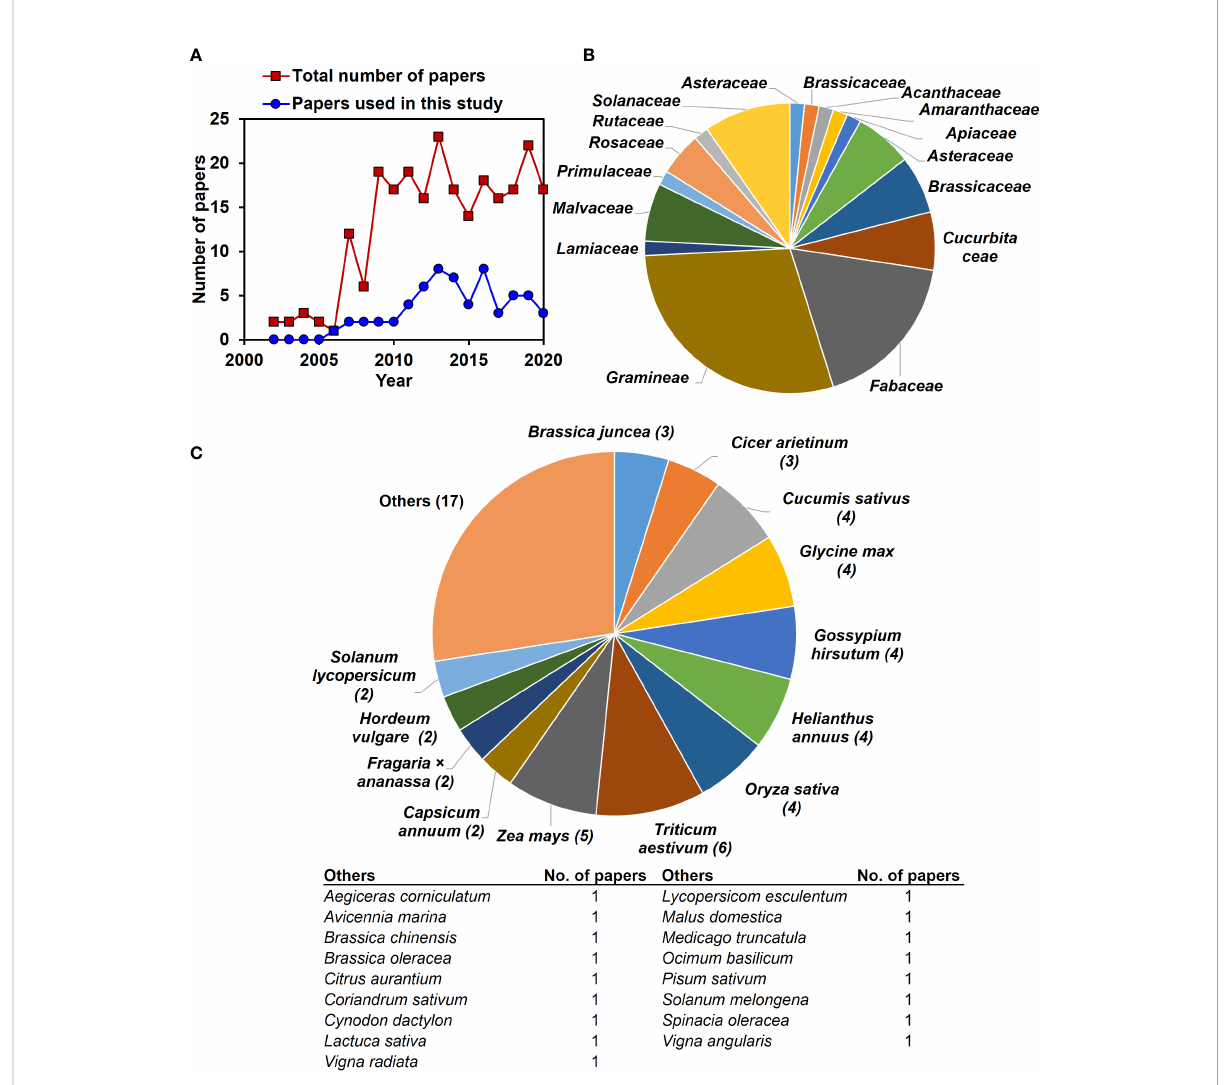
FIGURE 2 The total number of published articles, plant families and species about exogenous NO effects on plant stress physiology for salt tolerance available in the ‘ Web of Science ’ and ‘ Scopus ’ databases between 2000 and 2020, (A) the inlets in the main plots display the total number of articles found in the search, while the main plots exhibit the number of publications by year. (B) The pie chart represents the sixteen diverse families of the studied plants. (C) The pie chart shows the 30 diverse plant species from 16 families across the used articles in this